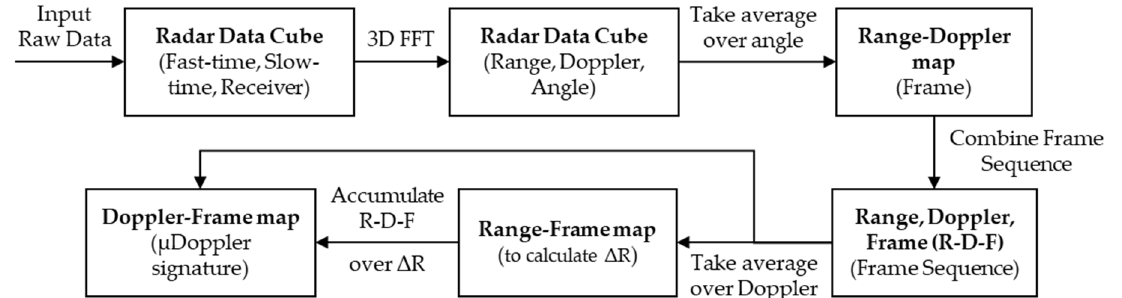
Figure 4. The signal pre-processing pipeline for the gait biometric used to extract the Doppler-frame heat map.